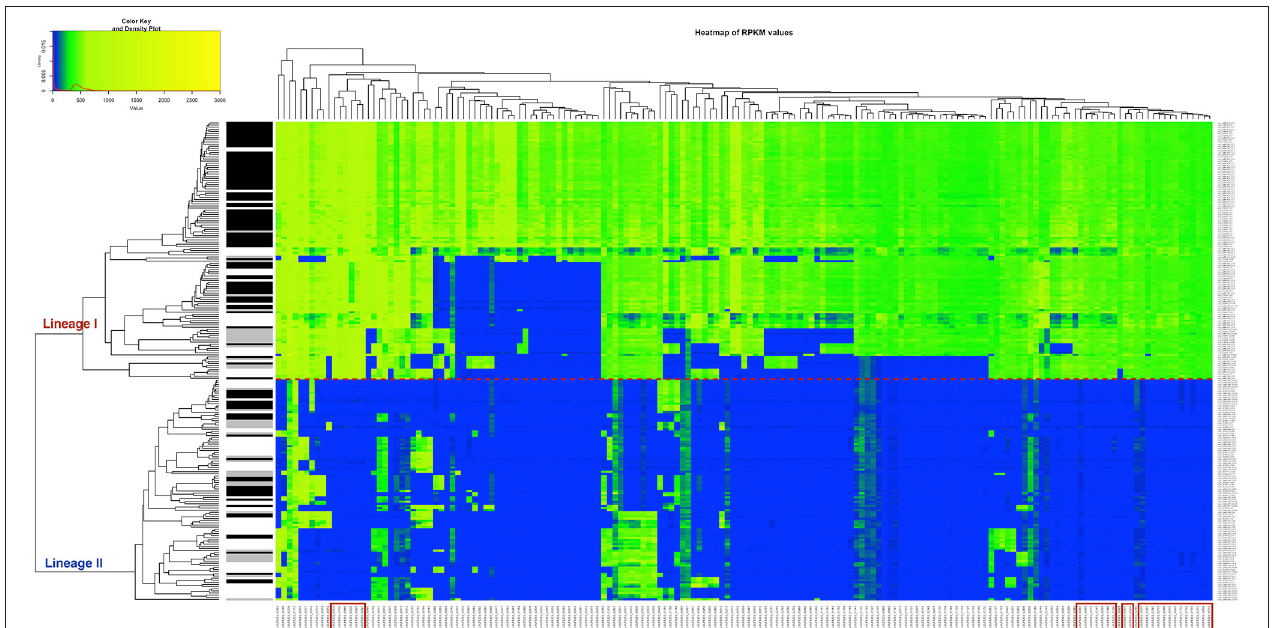
FIGURE 5 | Heatmap of the RPKM values per gene for the 167 selected genes in the 225 sequenced strains after the comparison between the two lineages. Red line: separation between the lineages I and II. Gray scale color bar corresponds with the source of infection: black, CNS infection strains and one septicemia case; gray, other clinical manifestations; white, environmental and two food strains. Red boxes denote genes that are specific to lineage I.